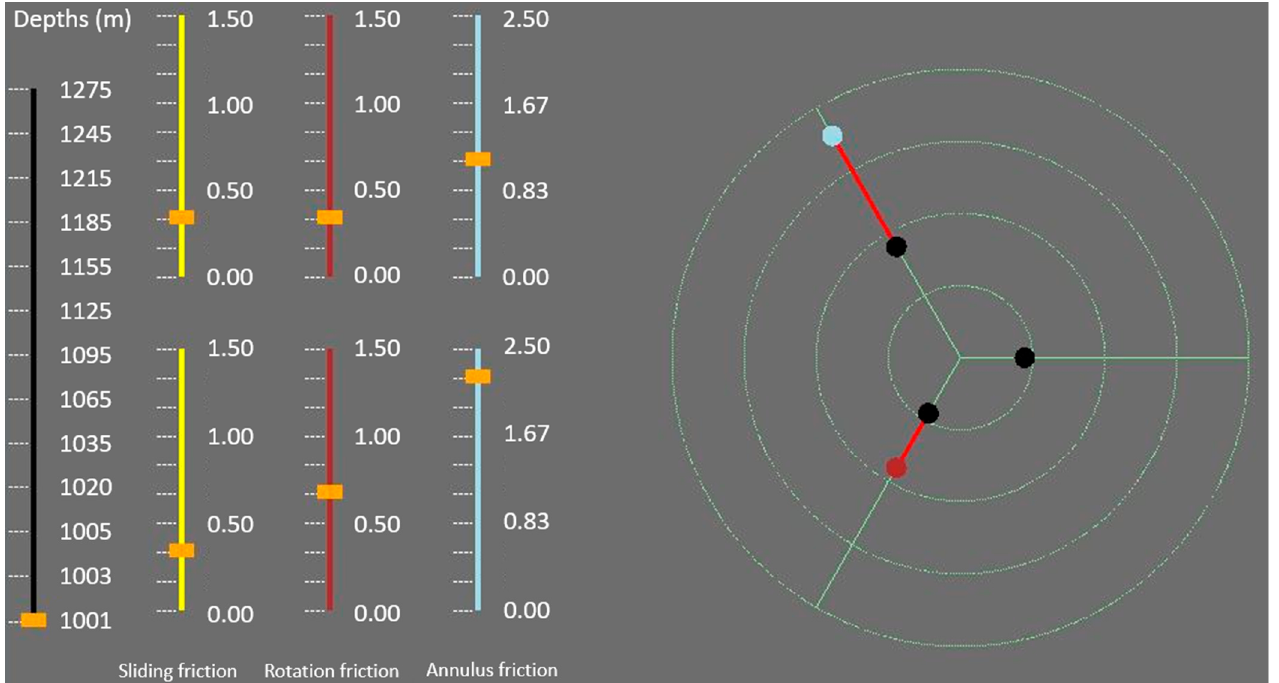
Figure 7. Graphical representation of a state. The bar on the left corresponds to the depth discretization used to evaluate the drilling of the entire section. The state analysis is performed with a high depth resolution at the start, and lower resolution afterwards. The other bars show the different frictions: sliding (left), rotation (middle), annulus (right) with the downhole ones on the bottom bars and the estimated ones (for the safety triggers) on the top row. The radar plot on the right is a condensed representation: the three axes correspond to the three friction types, the black points to the estimated ones and the colored points to the downhole one. In the case where the downhole friction is higher than the estimated one, a red line is drawn between the two points. The line is green otherwise (not shown in this example).